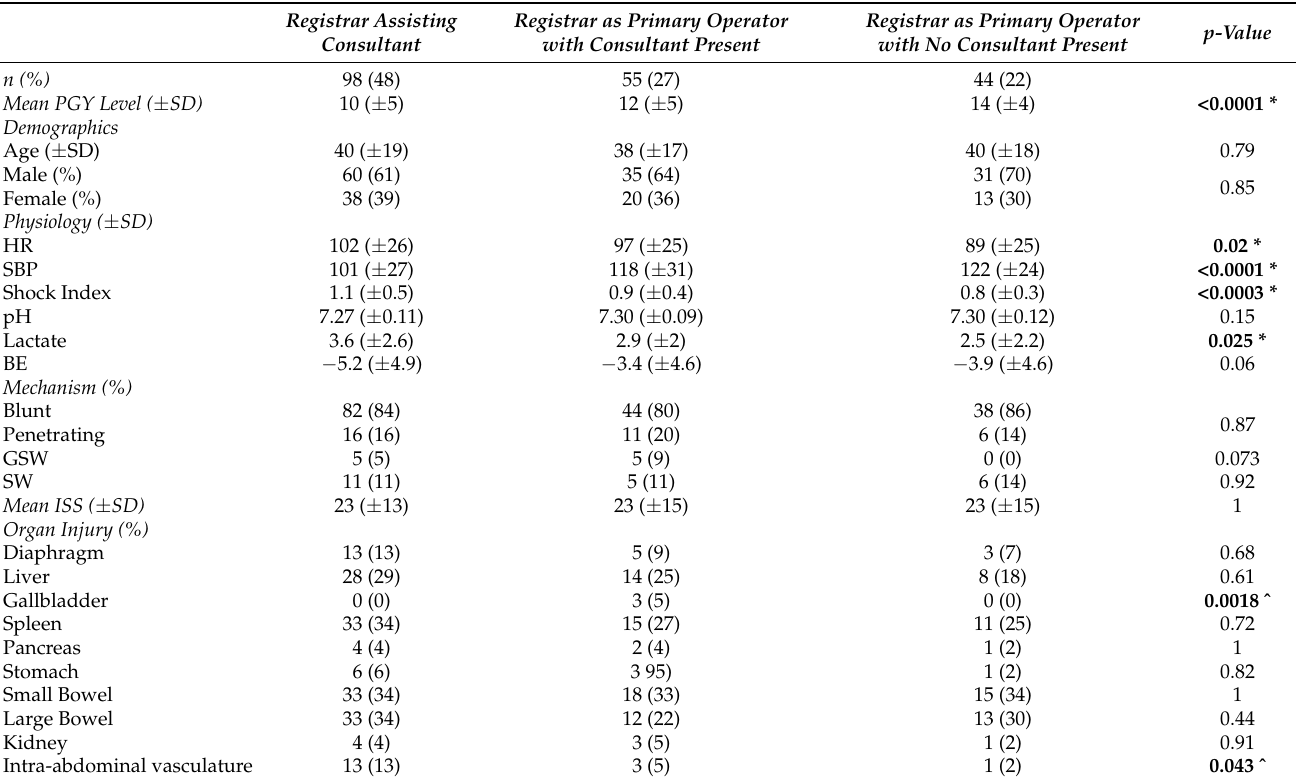
Table 1. Registrar assisting trainer vs. registrar as primary operator with trainer present vs. registrar as primary operator with no trainer present: mean PGY of the registrar, patient characteristics, and organ